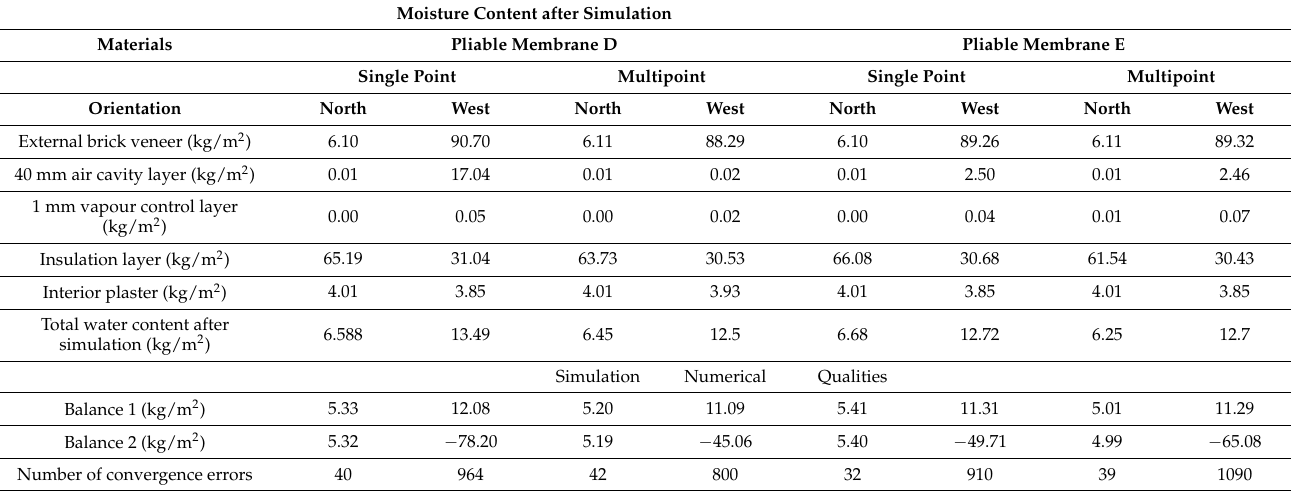
Table A6. Hygrothermal calculation result for Holzkirchen with wind-driven rain